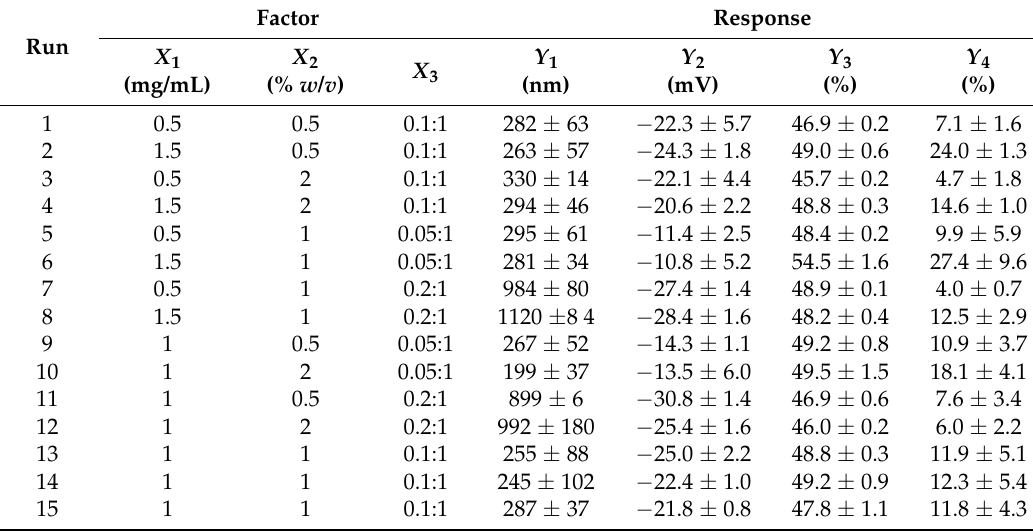
Table 1. Factors and observed responses in the Box-Behnken statistical design for optimization of the Cur-CS/Alg NP formulation.